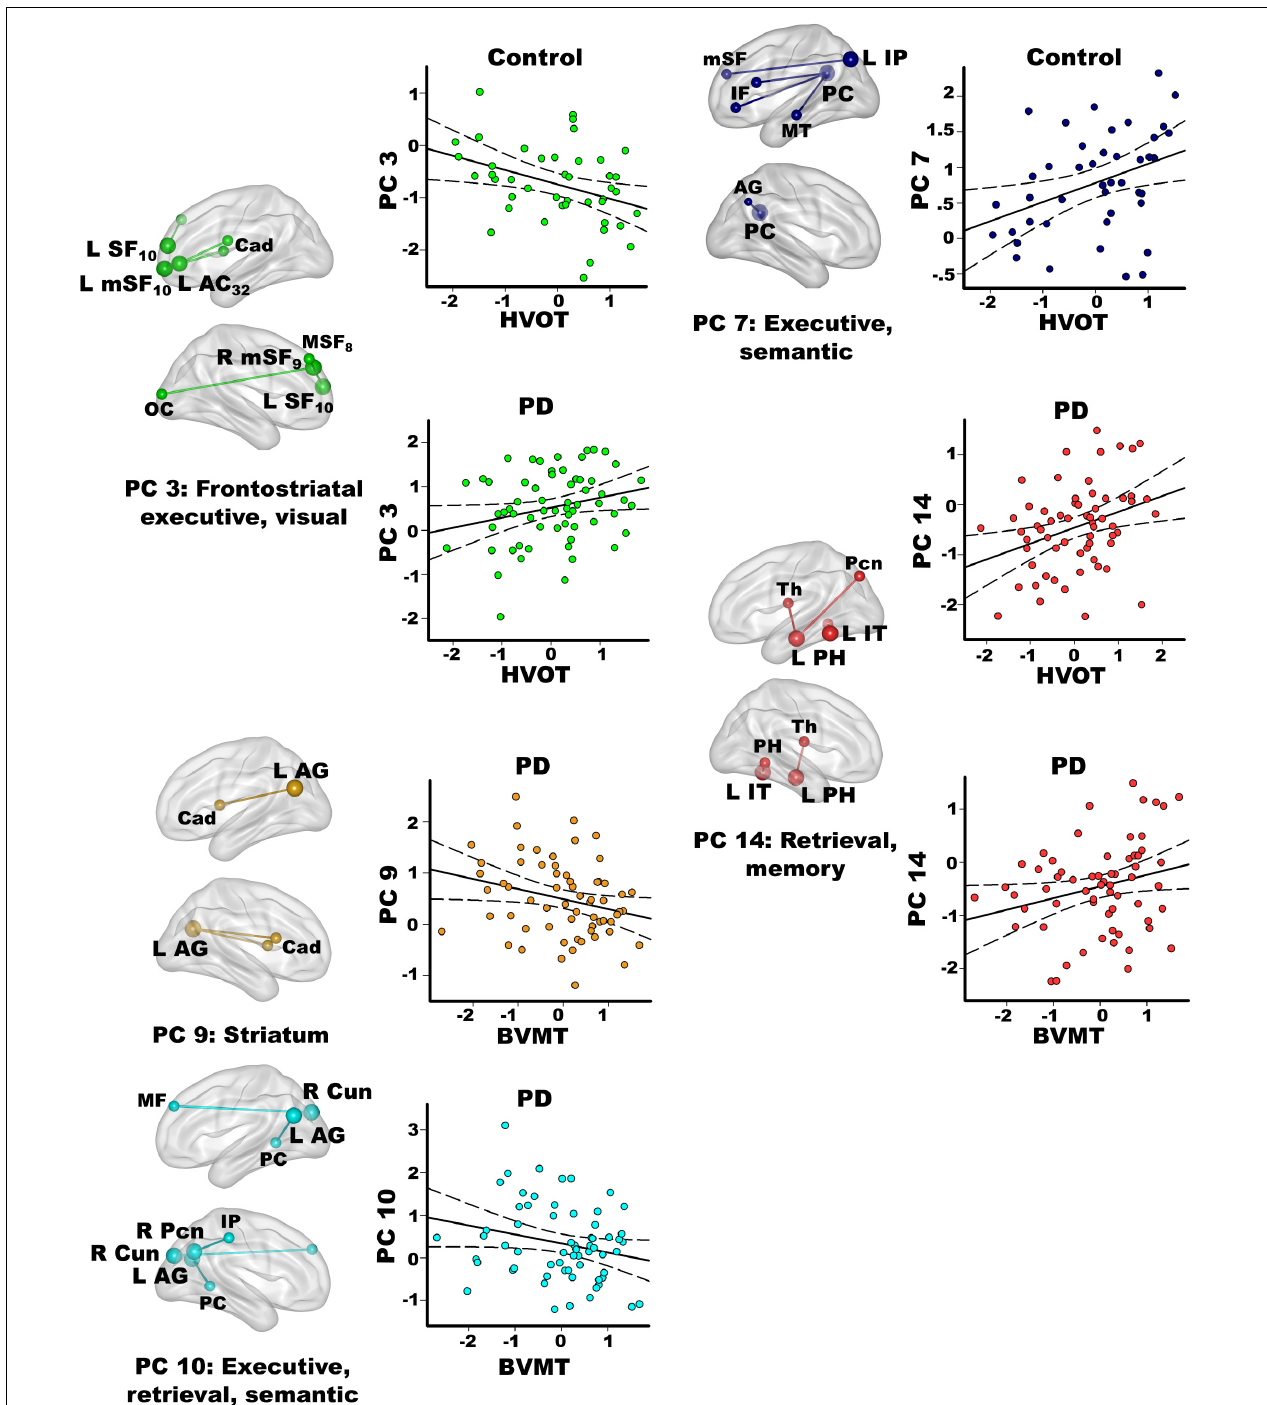
FIGURE 5 | Relationships between principal component scores and interrelated cognitive functions. Visual organization and naming (Hooper Visual Organization; HVOT) and episodic memory (Brief Visuospatial Memory Test-Revised; BVMT) performances significantly correlated with specific principal component (PC) scores. For each PC, seed(s) (large balls) and their connection(s) (small balls) are color coded. Significant correlations between PC scores ( y axis) and age adjusted residuals for the cognitive tests ( x axis) are shown on scatterplots for the PD and the control groups. Plots display the best-fitting linear regression line (solid line) and 95% conference intervals (dotted lines). Brodmann areas for frontal seeds are designated by subscripts. L, left hemisphere; R, right hemisphere. AC, anterior cingulate; AG, angular gyrus; Cad, caudate; Cun, cuneus; IF, inferior frontal; IP, inferior parietal; IT, inferior temporal; mSF, medial superior frontal; MF, middle frontal; MT, middle temporal; OC, occipital cortex; Pcn, precuneus; PC, posterior cingulate; PH, parahippocampus; SF, superior frontal; Th, thalamus.